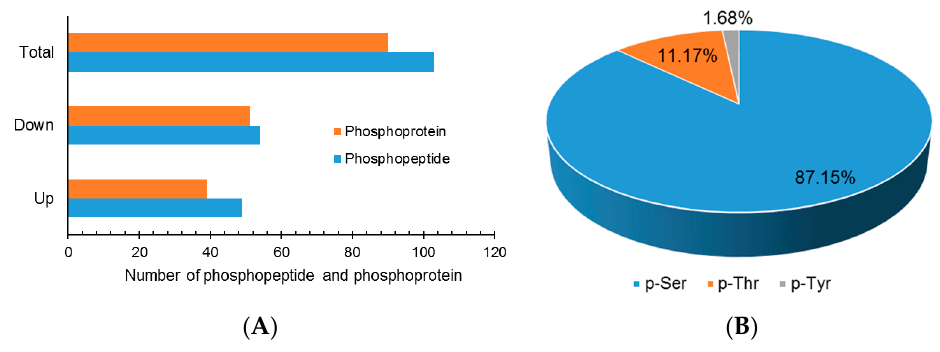
Figure 2. Differentially-expressed phosphopeptides and phosphoproteins in A. mongolicus roots under drought Stress. ( A ) Summary of the differentially-expressed phosphopeptides and phosphoproteins; and ( B ) distribution of serine phosphorylation (p-Ser), threonine phosphorylation (p-Thr), and tyrosine phosphorylation (p-Tyr) sites of the differentially-expressed phosphopeptides in A. mongolicus roots.